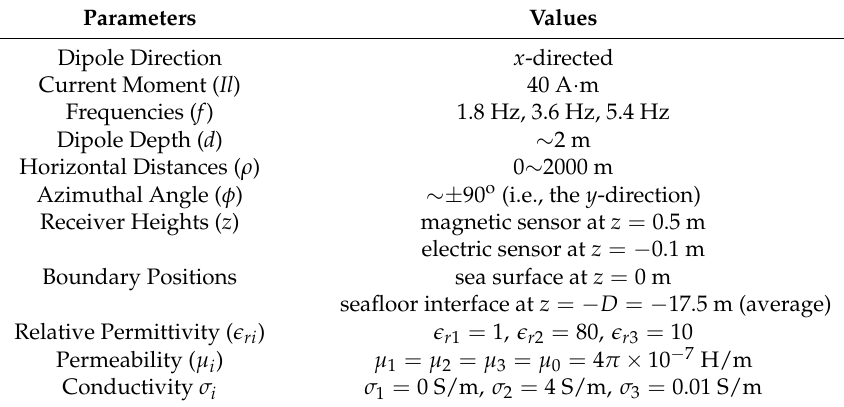
Figure 3. Comparisons of the simulated and measured electric field strength. ( a ) | E x | ; ( b ) | E y | . Table 1. The simulation conditions corresponding to the experiment